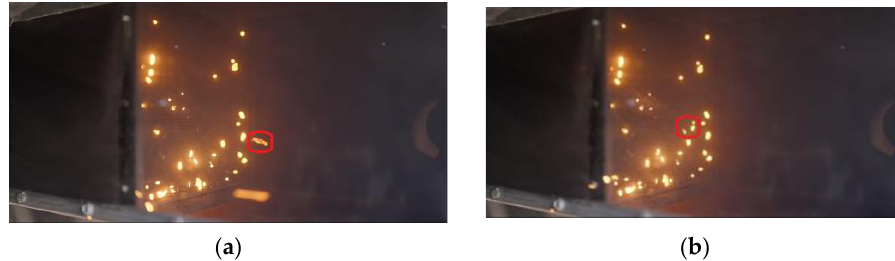
shows the state of the firebrand, ( a ) approaching, ( b ) stationary at hitting point, ( c ) producing Figure 9. Continuation of burning firebrands behind the mesh for 12.68 s. The encircled firebrand